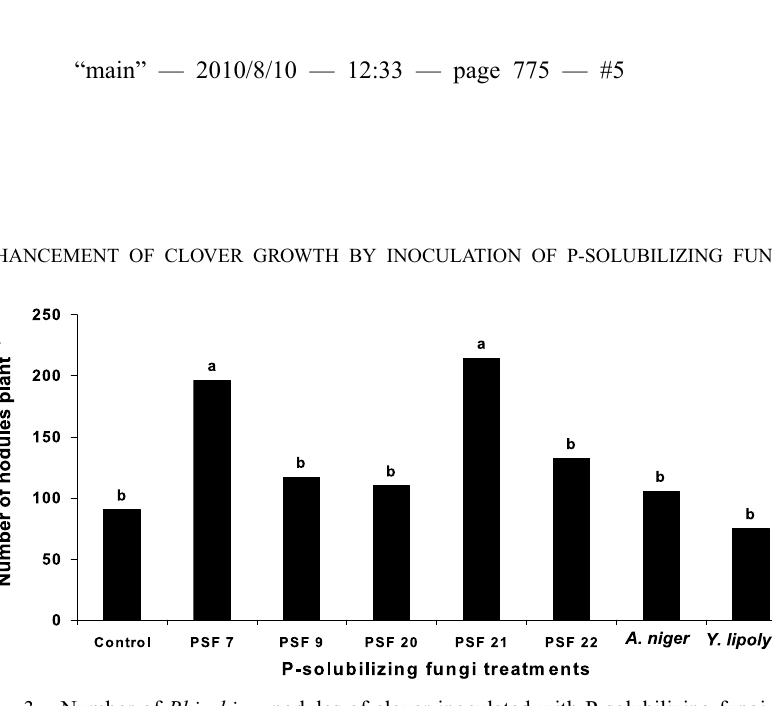
Fig. 3 – Number of Rhizobium nodules of clover inoculated with P-solubilizing fungi from Paraty, Rio de Janeiro, Brazil (PSF 7, 9, 20, 21 and 22) and from Granada, Spain ( A. niger and Y. lipolytica ). (Lower-case letters compare PSF treatments by the Scott-Knott test ( p ≤ 0 . 05 ) .